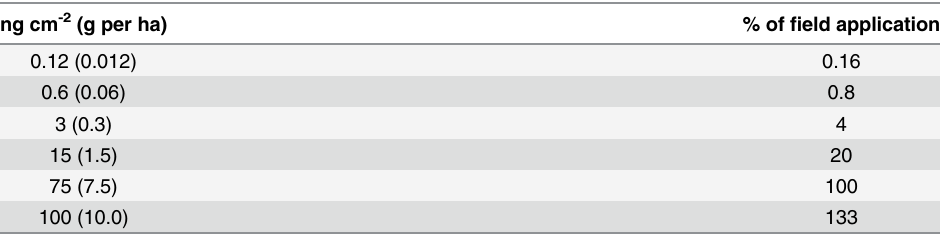
Table 1. Bioassay doses for cabbage stem flea beetles. The λ -cyhalothrin doses used in this study expressed in ng per cm 2 and % of field